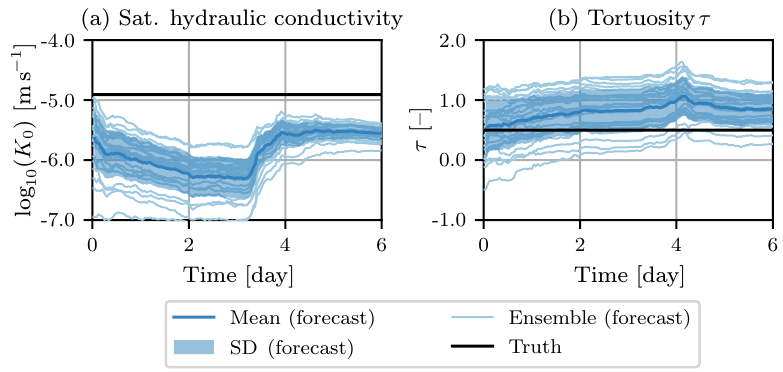
Figure 5. Development of saturated hydraulic conductivity K 0 and tortuosity τ for an estimation without inflation.